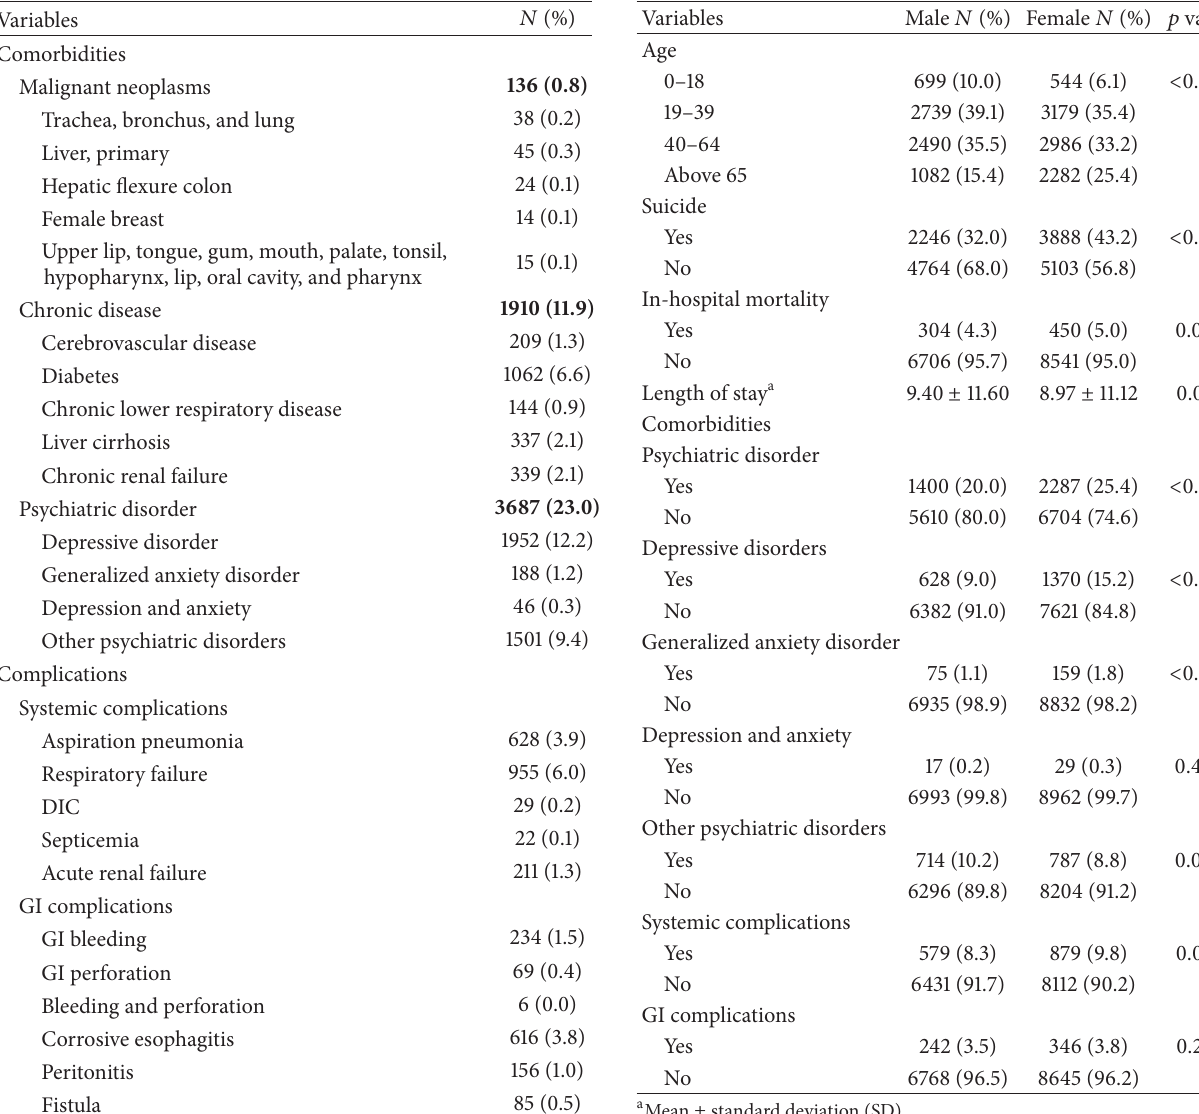
Table 2: Comorbidities and complications for corrosive injury patients, 𝑁 = 16,001.